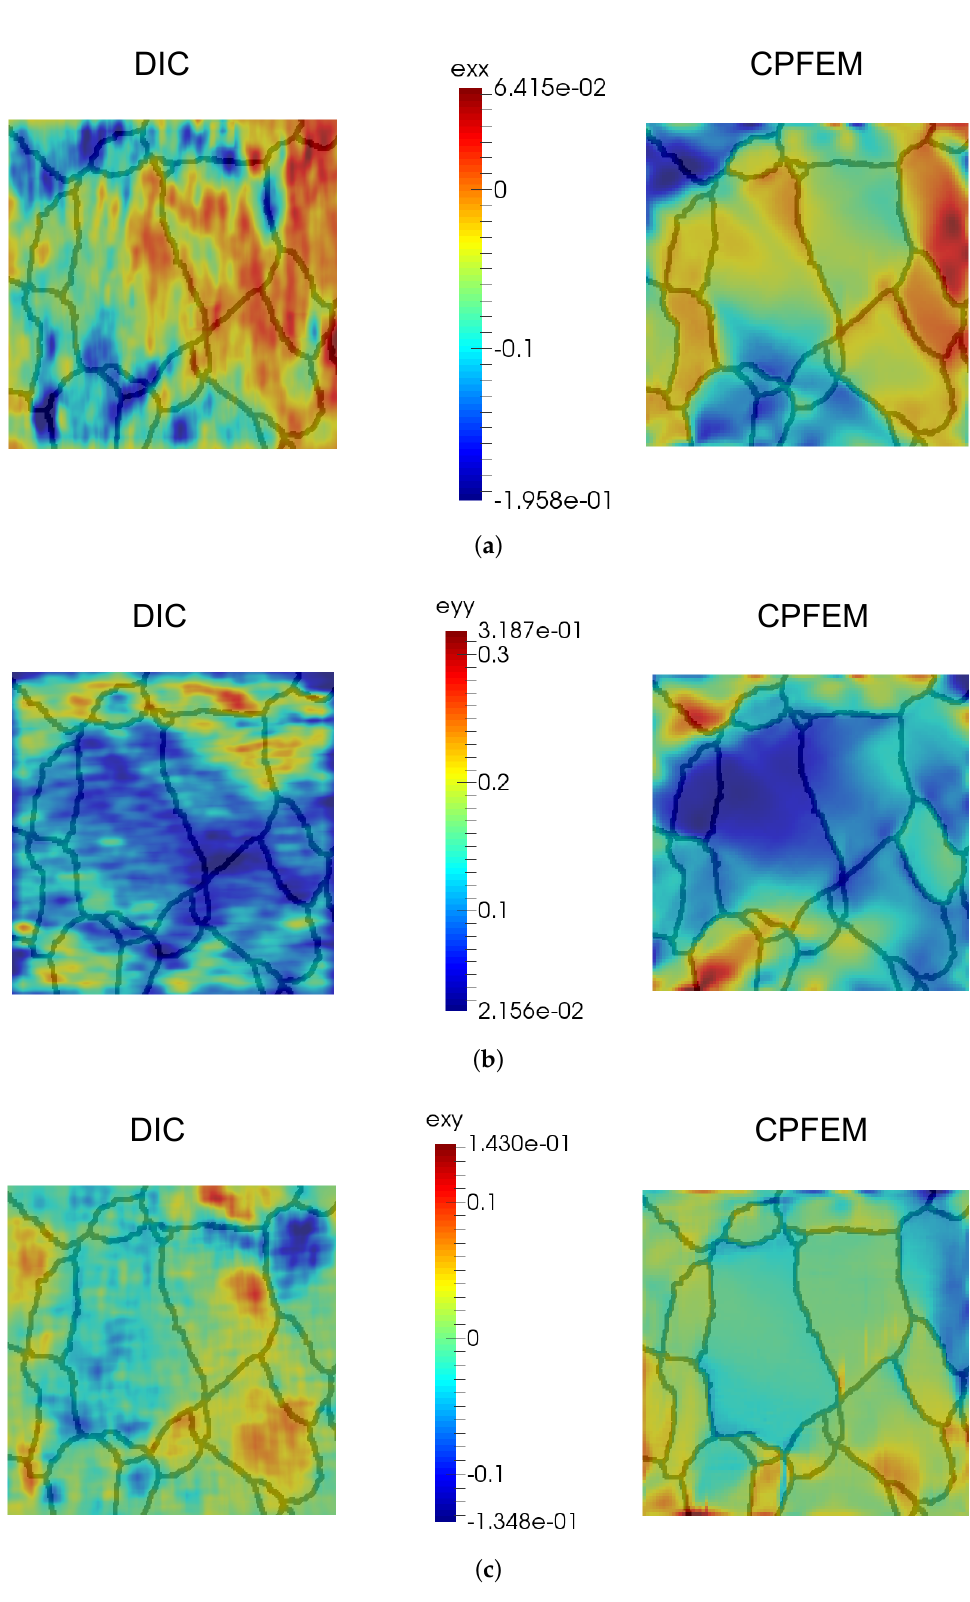
Figure 8. CPFE simulation and SEM-DIC data comparison for e xx , e yy and e xy strain fields. ( a ) e xx strain field; ( b ) e yy strain field; ( c ) e xy strain